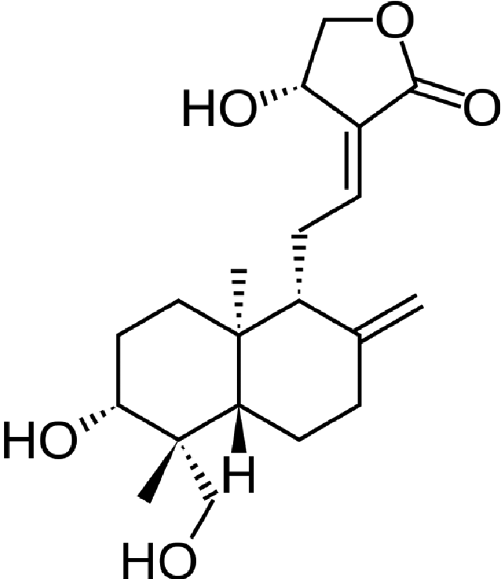
Figure 9. The structure of